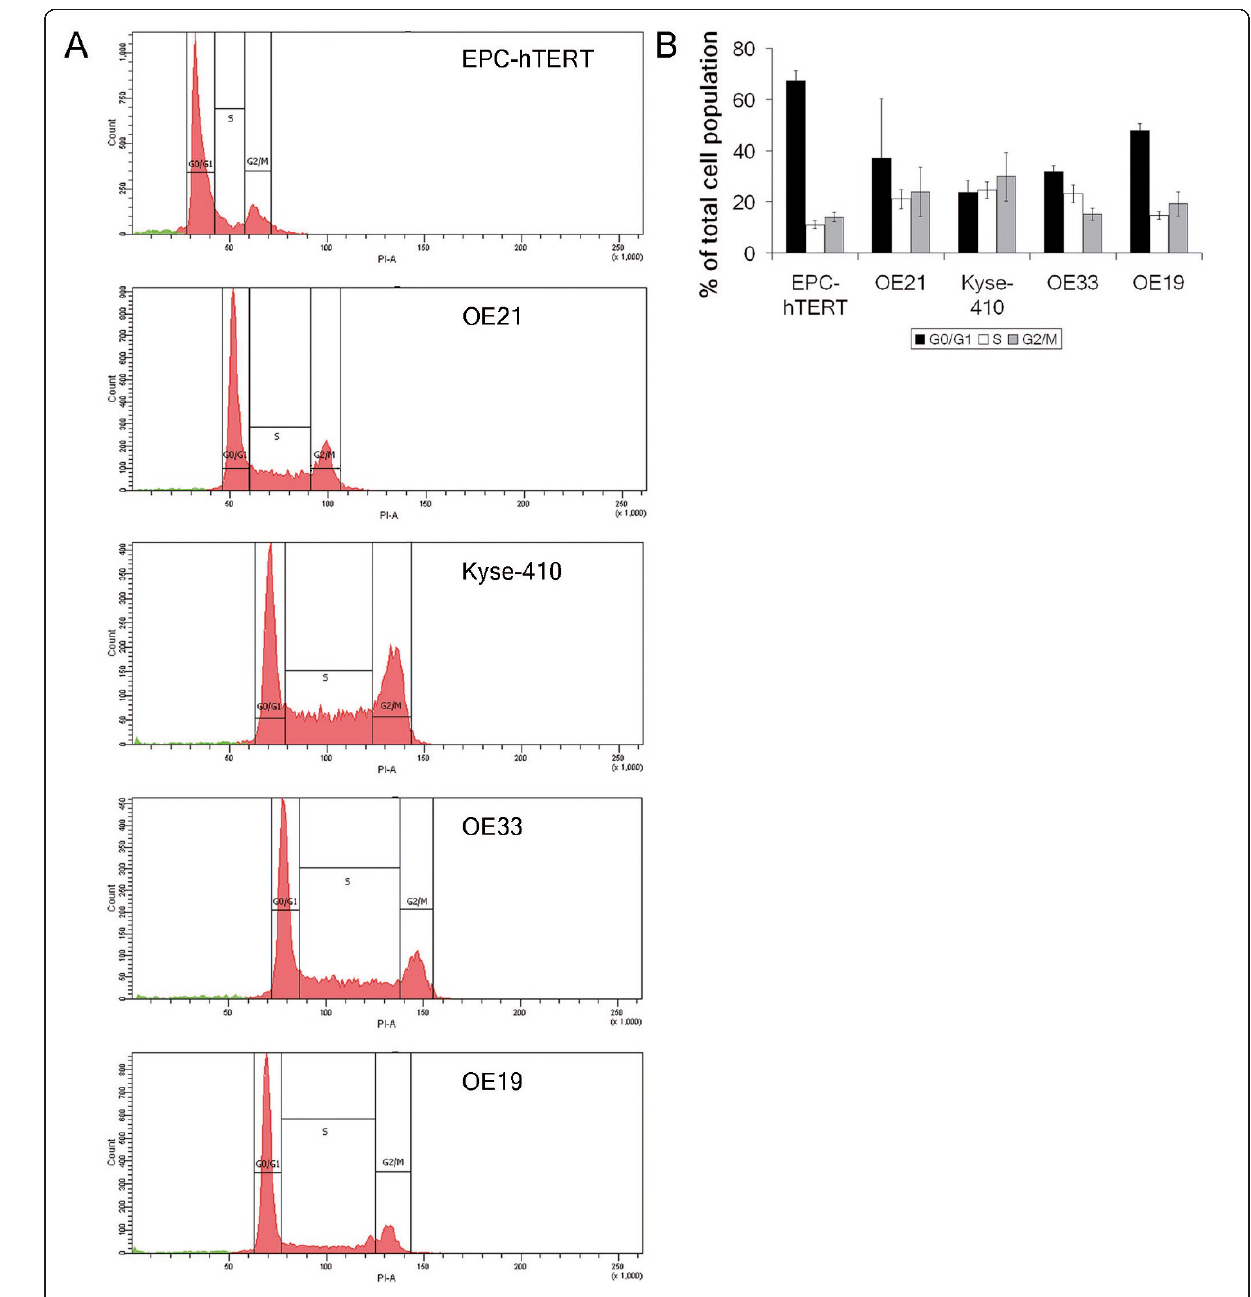
Figure 1 Cell cycle phase distribution analysis by flow cytometry in normal esophageal epithelial cells and esophageal cancer cells . A . The histograms show the cell cycle phase distribution, representative for 3 independent experiments. Note the increasing PI-staining/DNA content from EPC-hTERT cells to OE21, Kyse-410, OE33 and OE19 cells. Proliferating cells in red, apoptotic cells in green. B . The bar graph shows the distribution of cells in G0/G1-, S- and G2/M-phase of the cell cycle (mean and ± standard deviation of three independent mRNA expression, but detectable strong Aurora-A and protein expression was seen in OE33, but not OE21 and weak Aurora-A/phosphoT288 protein levels. OE19 cells. Active (phosporylated T288) Aurora-A was hardly detectable in immunoblot analysis, but weak Aur- ora-A/phosphoT288 levels were seen in OE21, Kyse-410 and OE33 cells. Control EPC-hTERT cells had normal diploid Aurora-A gene copy numbers, lowest Aurora-A